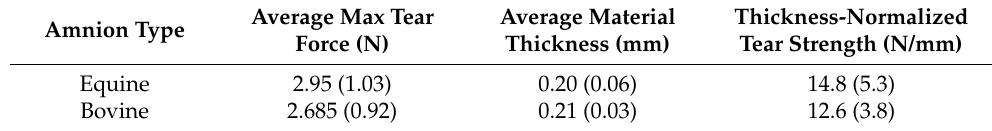
Table 1. Tear strength of chorioamnion.